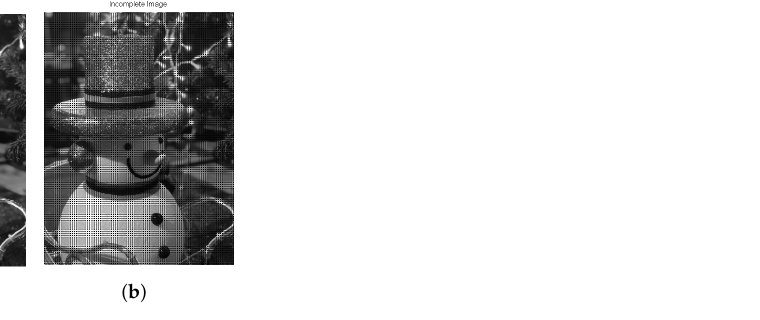
Figure 4. (Numerical Test 2) ( a ) Original image and ( b ) an incomplete image with 50% missing